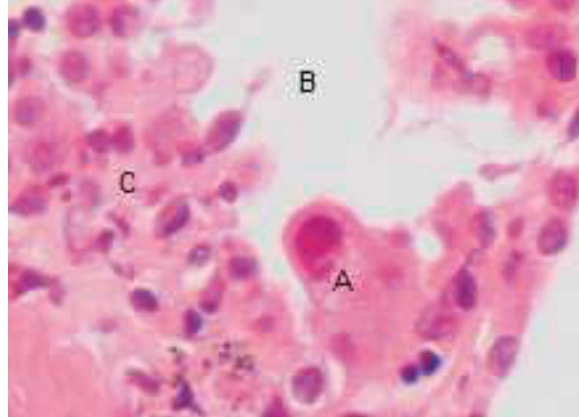
Fig. 3. Haematoxylin and eosin, high power. A = enlarged alveolar pneumocyte with brick-red intranuclear CMV inclusion body; B = alveolar space; C = alveolar wall showing a nonspecific inflammatory cell infiltrate. (Acknowledgement: Jill Murray, School of Public Health, University of the Witwatersrand and National Health Laboratory